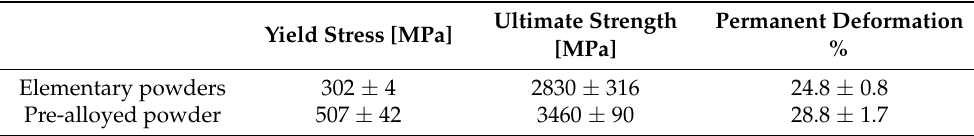
Figure 4. Comparison of strain-stress relationships of specimens obtained from elementary powders ( red ) and pre-alloyed powders ( blue ). Table 2. Strength parameters of specimens obtained from elementary powders and pre-alloyed powders.